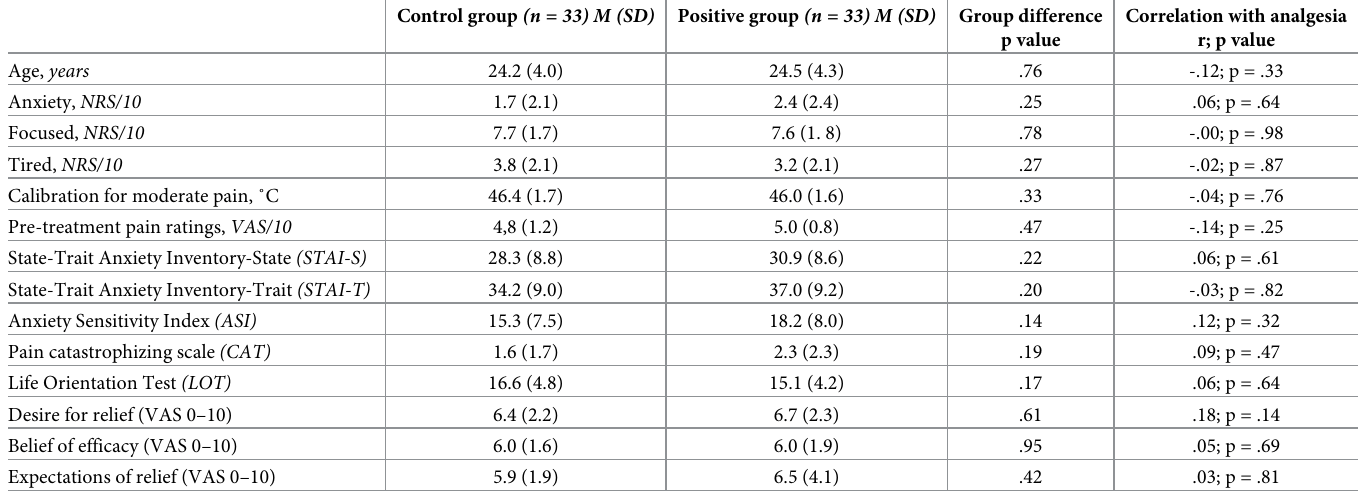
Table 1. Participants’ characteristics.